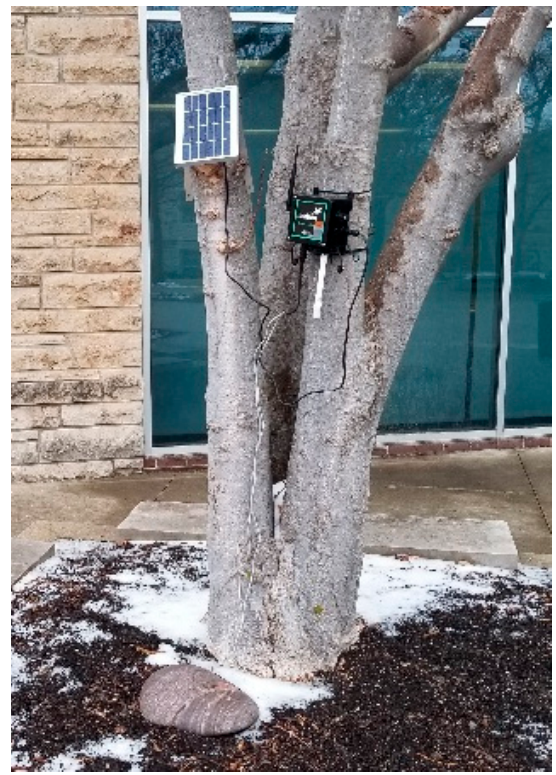
Figure 4. An actual WSN deployed in the field, using the same sensor modules tested in this